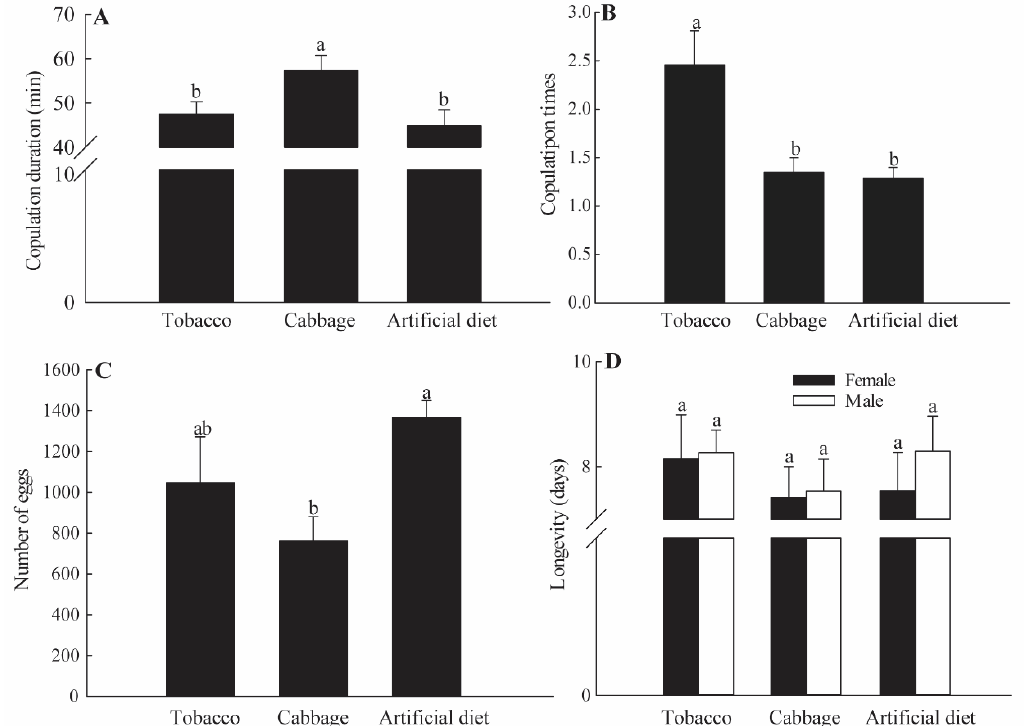
Figure 6. Copulation duration ( A ); copulation times ( B ); the number of eggs ( C ); and ( D ) longevity of Spodoptera litura in non-choice tests. Values are the mean ± SE ( n = 30), with different lowercase letters indicating significant differences ( p < 0.05, Tukey’s HSD multiple range test).